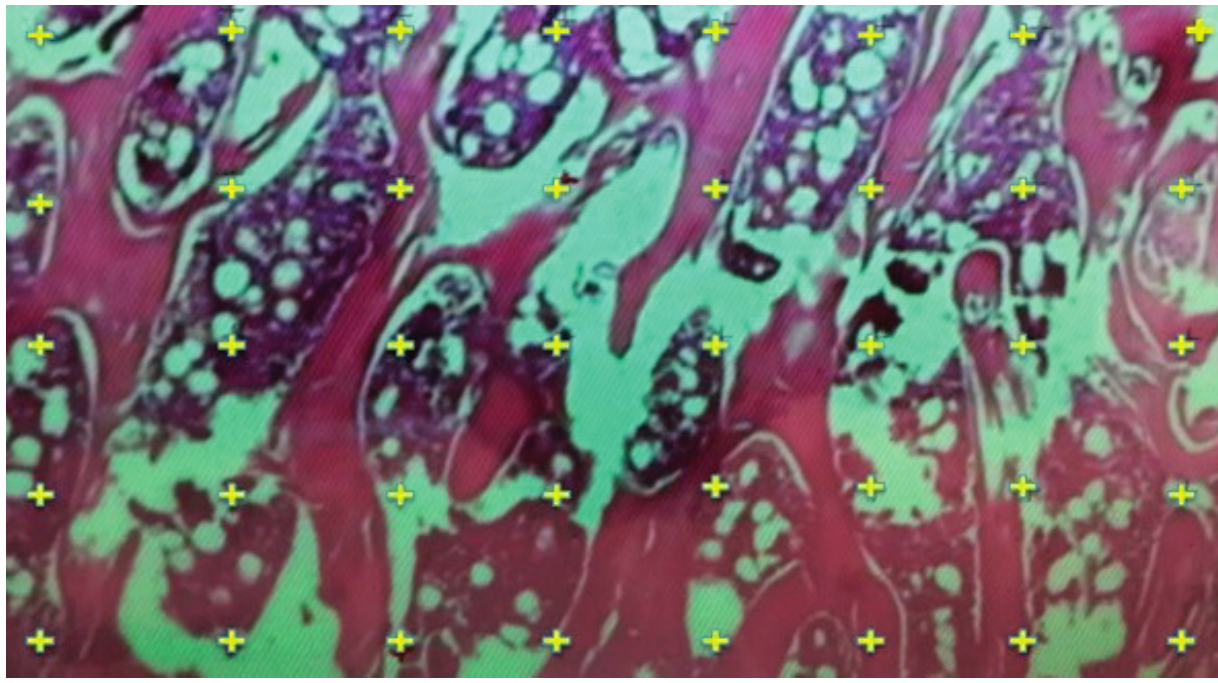
Figure 2. Measurement of trabecular bone thickness and determination of number of trabeculae (on a chart area of approximately 878 × 1250 µm 2 at 4× magnification) on the histologic specimen (specimen from Group